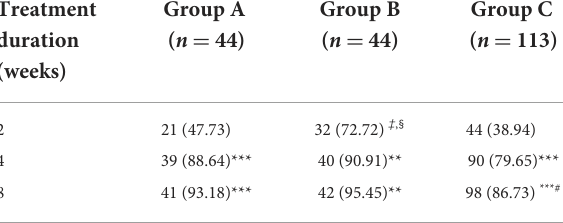
TABLE 3 The remission rate of global gastrointestinal symptoms in patients with functional dyspepsia with mood disorders ( n [%]). Treatment duration